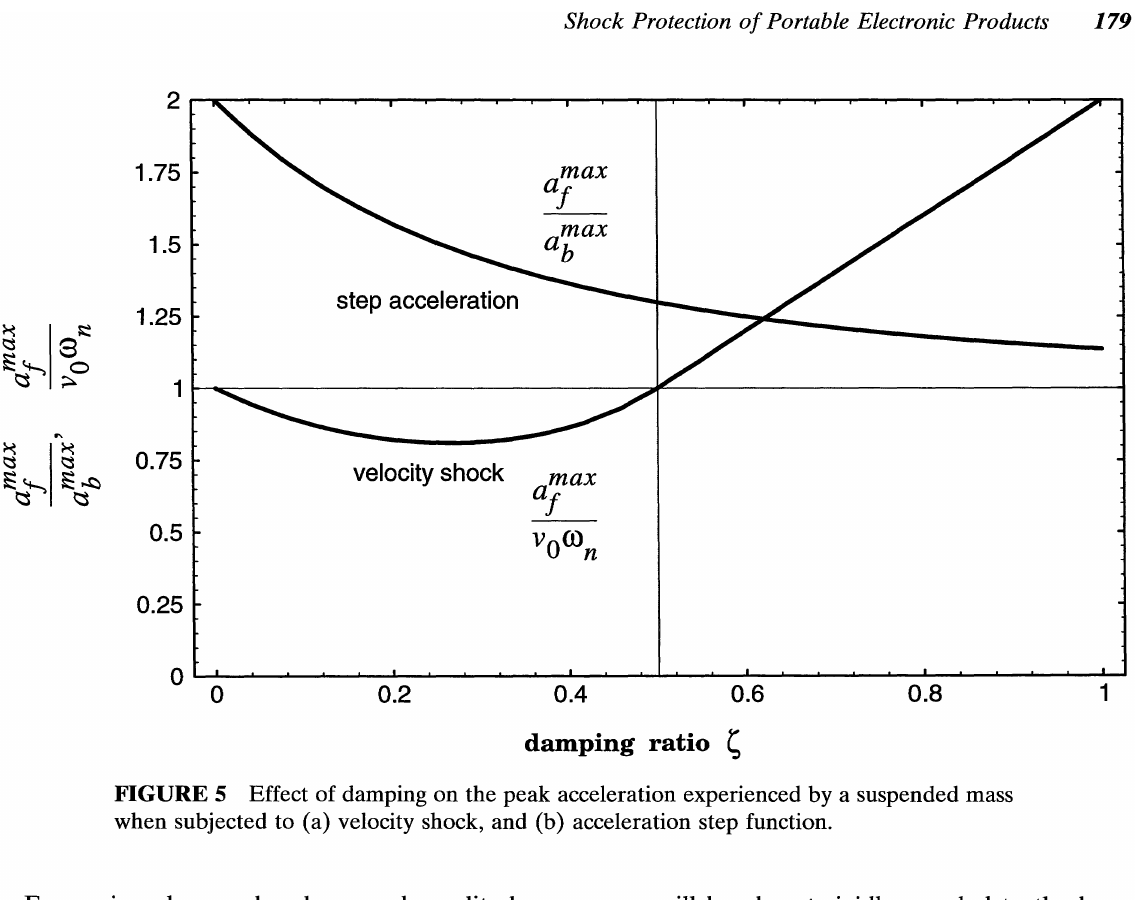
F1GURE 5 Effect of damping on the peak acceleration experienced by a suspended mass when subjected to (a) velocity shock, and (b) acceleration step